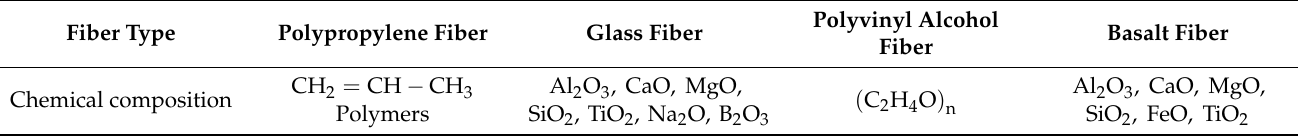
Table 2. Chemical composition of different fibers.